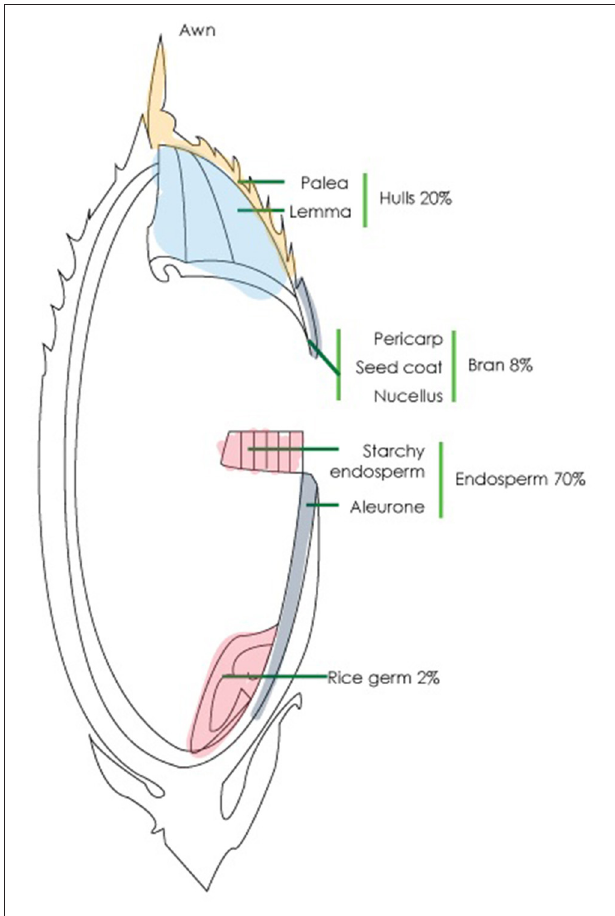
FIGURE 1 | Structure of rice whole grain. The grain consists of four main parts, namely, hulls (20%), bran (8%), endosperm (70%), and germ